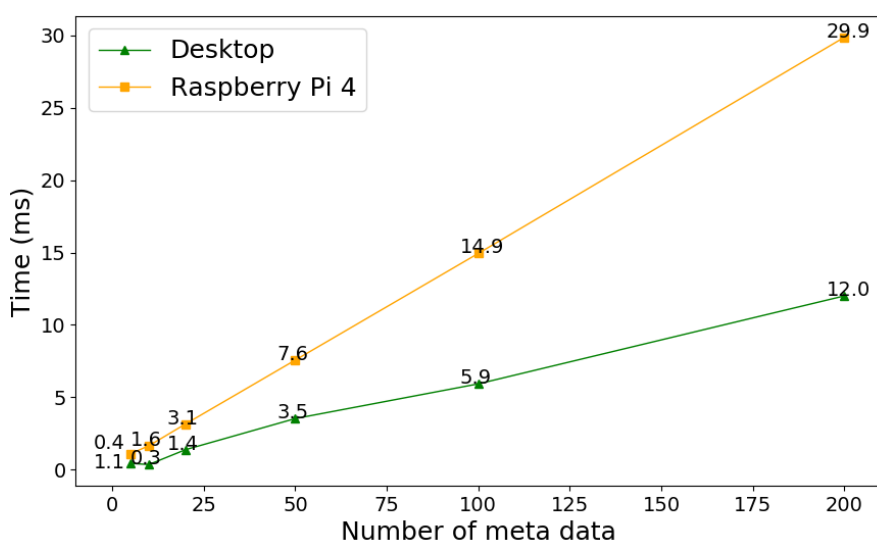
Figure 6. Processing time by data token validation on different platforms.